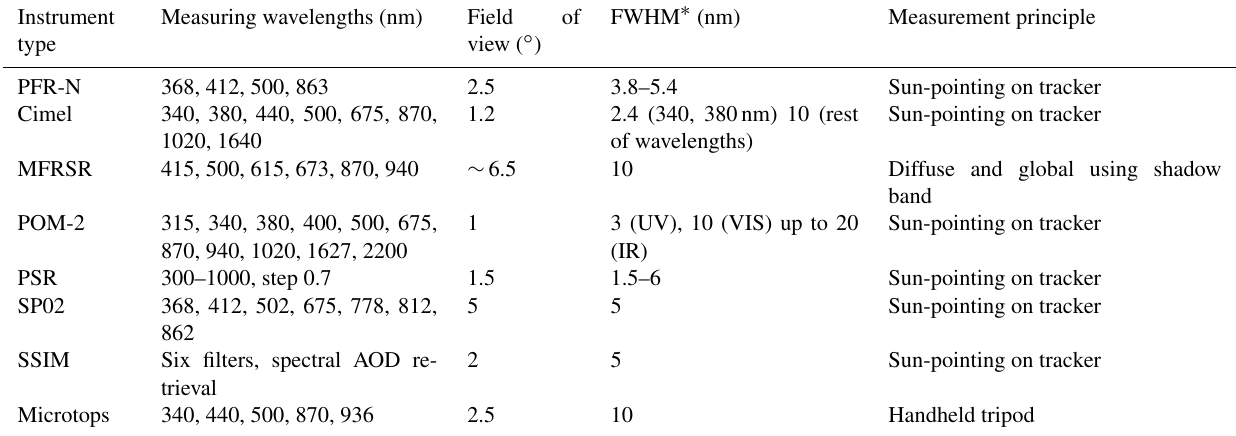
Table 1. Details of sun photometers used during the FRC-IV intercomparison campaign. Instrument type